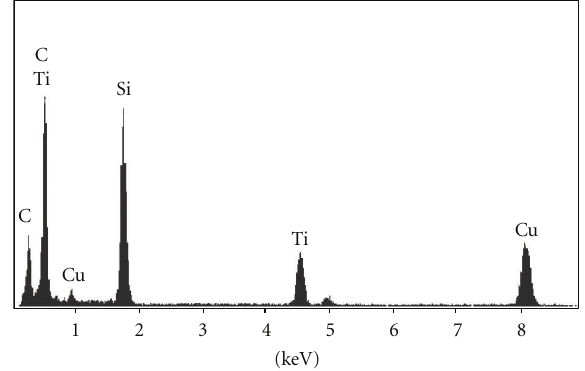
Figure 6: EDS spectrum of TiO 2 /MCM-41